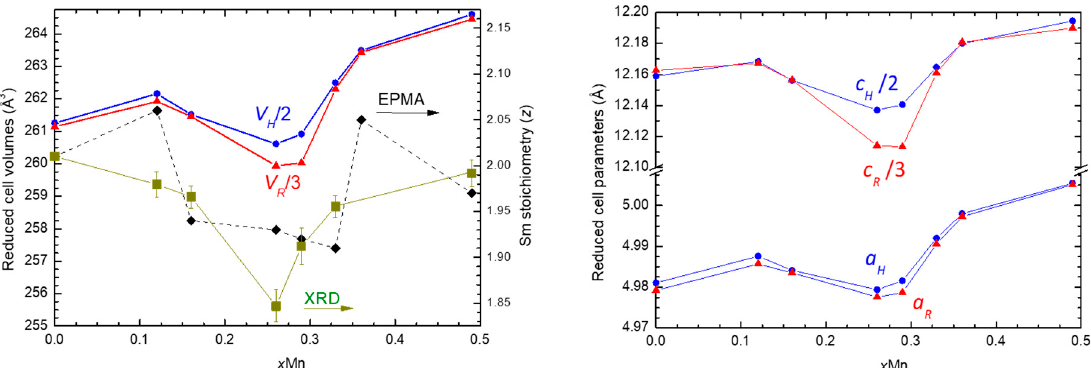
Figure 3. ( left frame ) Evolution of the reduced cell volumes ( V H / 2 (blue circle) and V R / 3 (red triangle) (left axis) and Sm concentration obtained by EPMA (black diamond) and XRD analysis (green square)(right axis) as a function of x for Sm 2 Mn x Ni 7 − x ; ( right frame ) Individual variations of the reduced cell parameters ( a H , c H /2, a R , c R /3).